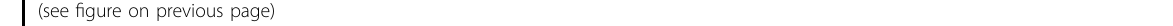
Fig. 8 hsa_circ_101555 promotes HCC tumor growth in vivo. A Schematic diagram shows that HCCLM3 cells were injected subcutaneously into BALB/c nude mice for 15 days to create tumor xenografts. After 15 days, 10 nmol cholesterol-modi fi ed hsa_circ_101555 shRNA or negative control shRNA was subcutaneously injected at the tumor site every 3 days for 18 days. B Representative images of HCC tumor bearing BALB/c nude mice. C Body weight of xenograft nude mice. D Body weight measured every 3 days. E Tumor volumes measured every 3 days (* P < 0.05; ** P < 0.01; *** P < 0.001; n = 4). F Relative weights of tumors (*** P < 0.001; n = 4). G IHC staining and IHC analysis of Ki-67 expression in subcutaneous xenograft tumors. Knockdown of hsa_circ_101555 downregulates Ki-67 expression (* P < 0.05; n = 4). H – J Expression of hsa_circ_101555, miR-145-5p and CDCA3 in subcutaneous xenograft tumors (** P < 0.01; *** P < 0.001; n = 4). K Protein expression level of CDCA3 in seven paired HCC and normal tissues (** P < 0.01; n = 4). L IHC staining and IHC analysis of CDCA3 expression in subcutaneous xenograft tumors. Knockdown of hsa_circ_101555